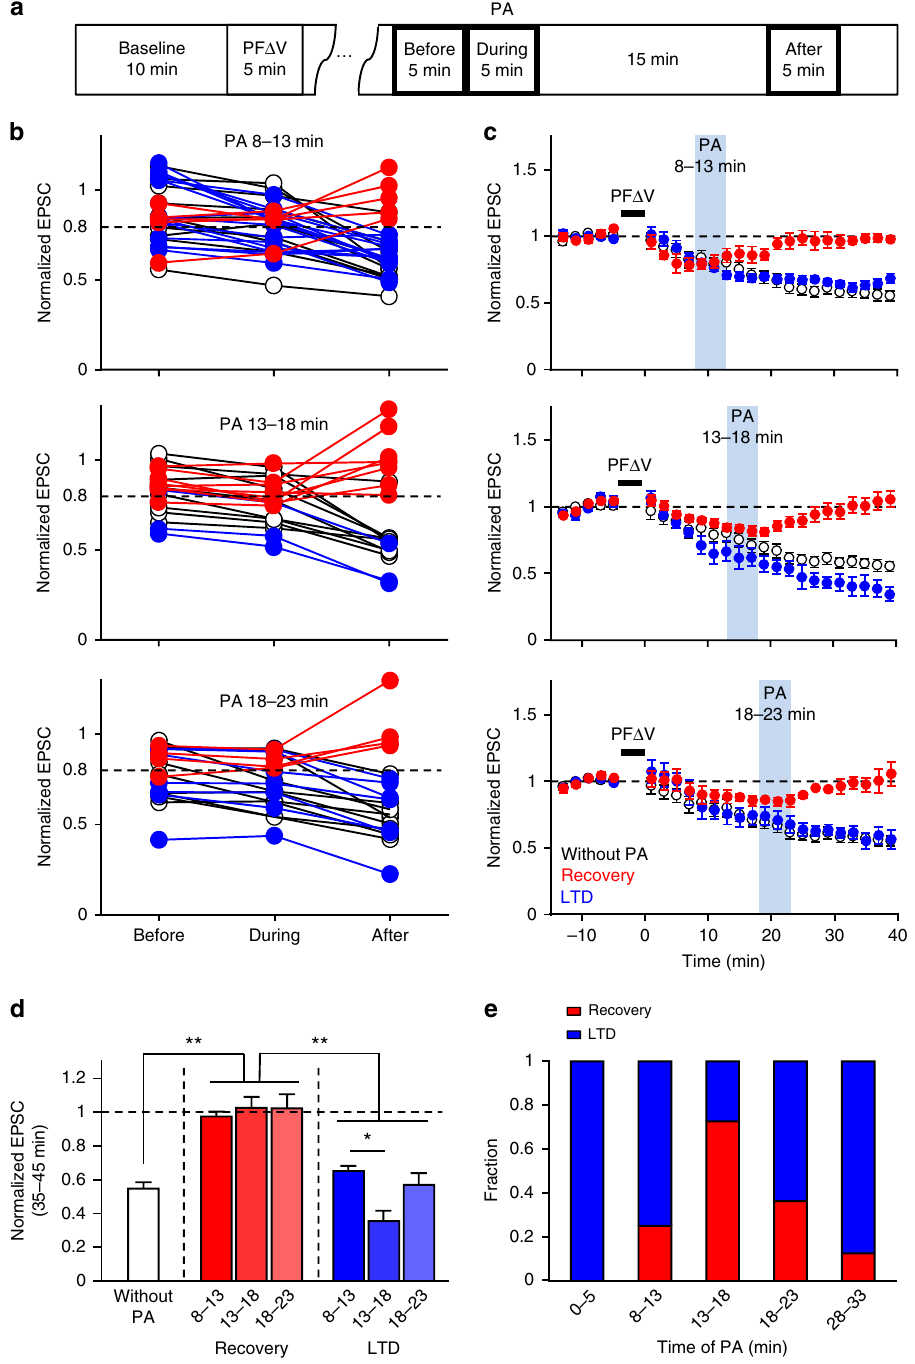
Fig. 7 Two distinct, all-or-none responses of LTD to the transient inhibition of LE sorting. a Diagram demonstrating the time periods used for the calculation of the simpli fi ed time course shown in b . PF-EPSCs recorded during each of the three periods (before, during, and after) were averaged. b Amplitudes of normalized PF-EPSCs before, during, and after the photoactivtion applied at 8 – 13, 13 – 18, or 18 – 23 min after the end of PF Δ V. Individual results showing PF-EPSC amplitudes larger or smaller than 0.8 after the photoactivation are shown in red or blue circles , respectively. Individual results of the experiments without photoactivation are shown in open circles . c Averaged time course of LTD in the recovery ( red circles ) or LTD ( blue circles ) group. Control LTD without photoactivation is overlaid ( open circles ). d Average amplitudes of normalized PF-EPSCs at 35 – 45 min after PF Δ V in the recovery or LTD group. * P < 0.05, ** P < 0.01, one-way ANOVA followed by the Tukey ’ s multiple comparison test. e Fractions of the recovery ( red ) or LTD ( blue ) group among all recordings with photoactivation at various timings. Exact P values for the data sets in this fi gure are provided in Supplementary Table